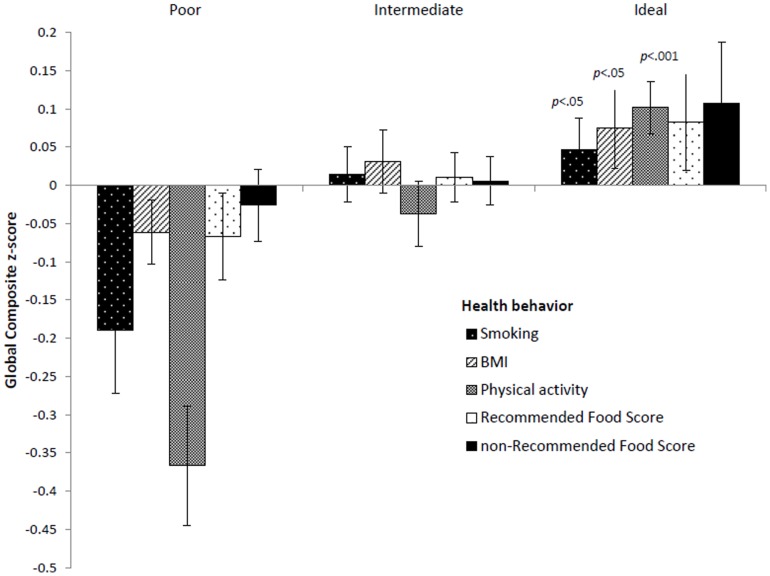
Mean Global Cognition Composite scores according to cardiovascular health level for each health behavior.Scores are mean Global Composite z-scores (and standard errors) for poor, intermediate and ideal health categories for smoking, BMI, physical activity, Recommended Food Score, and the non-Recommended Food Score, adjusted for age, education and gender. p-values are for significant linear trends.